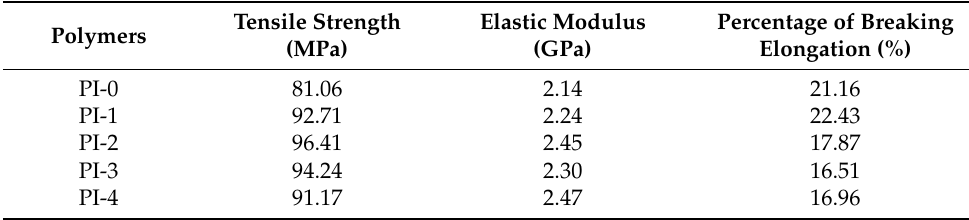
Table 5. Mechanical properties of PI films.